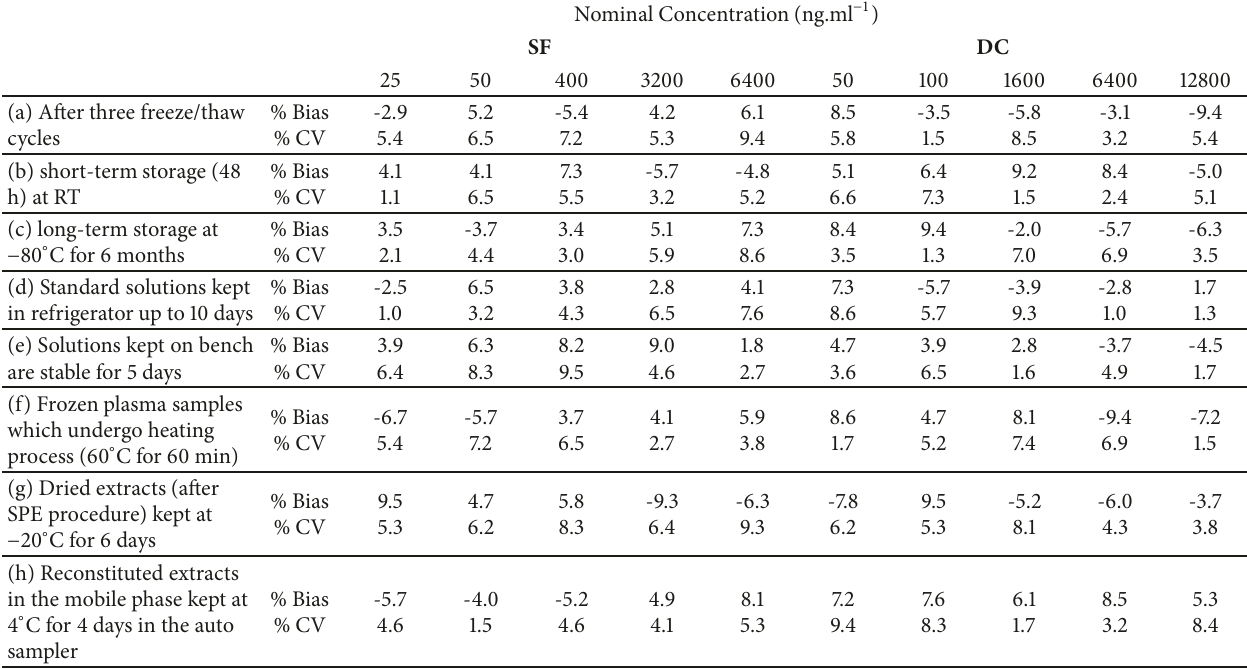
Table 3: Stability of SF and DC in plasma samples under several storage